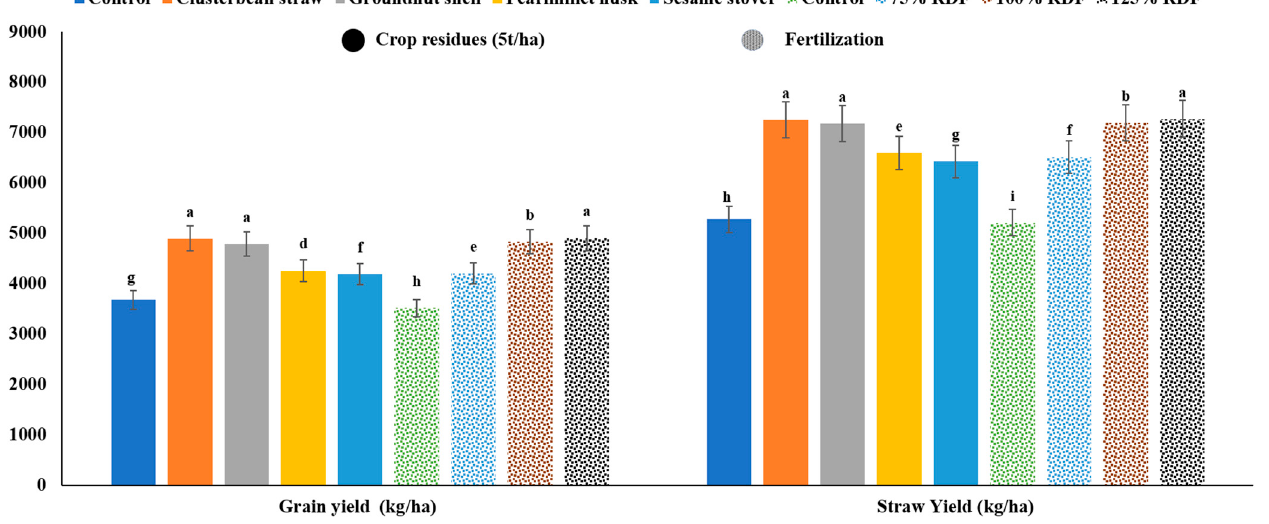
Figure 6. Effect of crop residues and fertilization on wheat yields (kg ha − 1 ) (grain and straw). In this figure, the values followed by different lowercase letters indicate no significant difference ( p > 0.05) by Duncan’s multiple range test (DMRT).